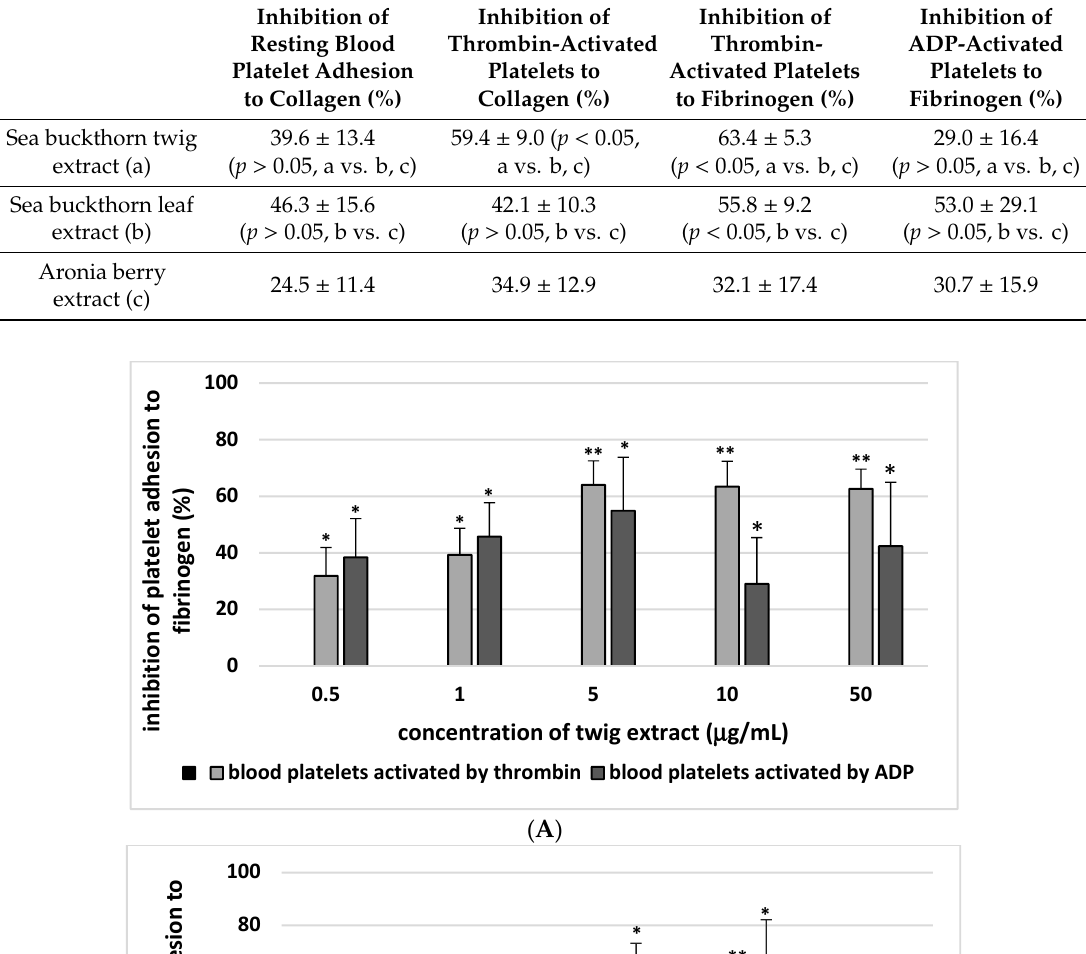
Table 1. Comparison of the e ff ects of sea buckthorn twig and leaf extracts and aronia berry extract at the concentration (10 µ g / mL) on blood platelet adhesion. Results are given as means ± SE of 5–9 healthy volunteers (experiments done in triplicate).and expressed in percentage (%) di ff erence between the control and tested extracts.